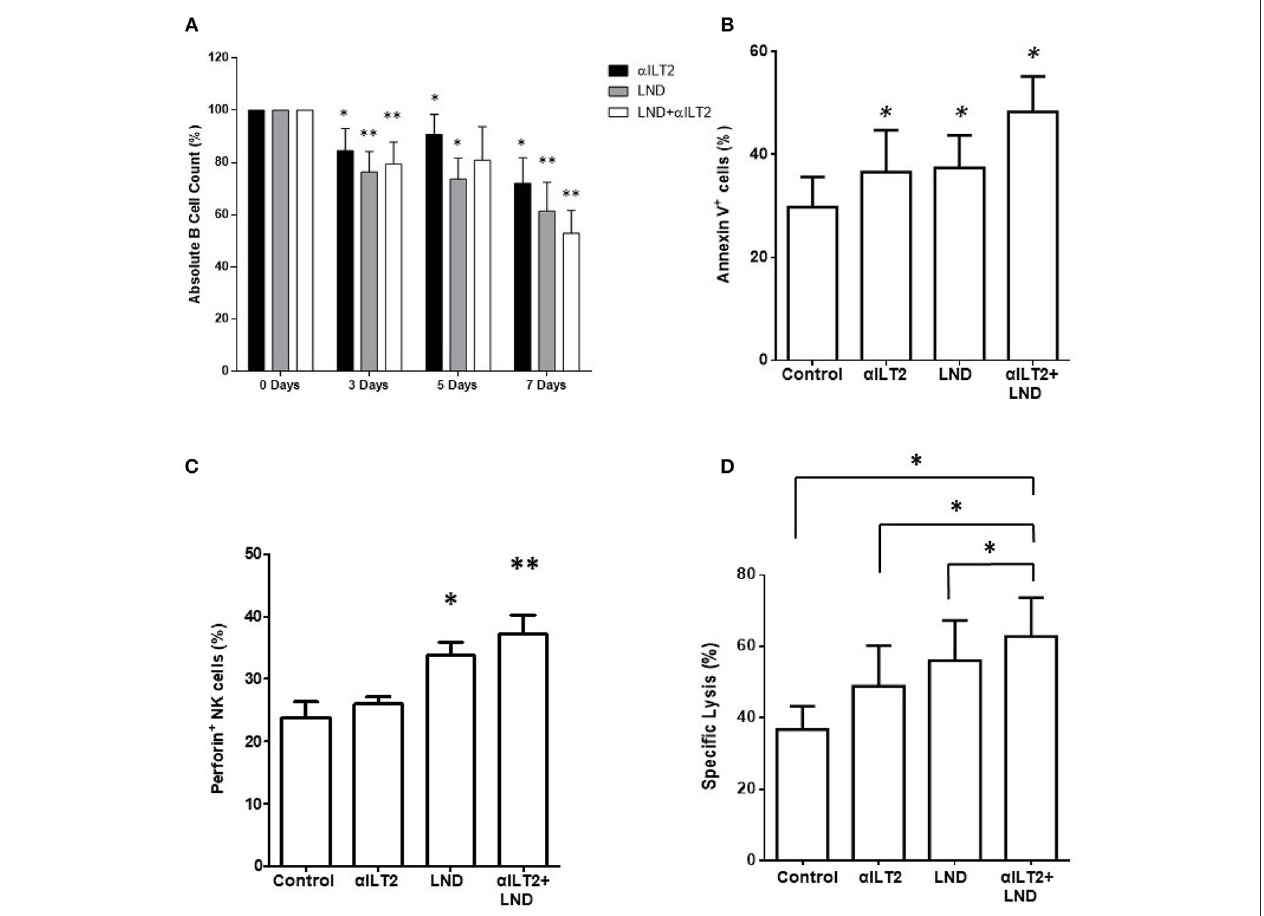
FIGURE 7 | ILT2 blockade and lenalidomide promote NK cell cytotoxicity and the elimination of primary leukemic cells from patients with CLL. PBMCs obtained from 6 CLL patients were cultured in the presence of anti-ILT2 blocking antibody (10 µ g/ml) or irrelevant IgG 1 and lenalidomide (LND, 1 µ M) for the time points indicated. (A) The absolute numbers of leukemic cells were then analyzed after 3, 5, and 7 days of treatment by staining with anti-CD19 antibody and PKH26 microbeads as a reference. (B) The effect of ILT2 blockade and lenalidomide (7 days) on the apoptosis of leukemic cells was evaluated by annexin V assay by flow cytometry ( n = 11). (C) NK cell intracellular perforin expression was evaluated by flow cytometry analysis in PBMCs from 6 patients with CLL upon 7 days of treatment with anti-ILT2 blocking antibody (10 µ g/ml) or irrelevant IgG 1 and lenalidomide (LND, 1 µ M). (D) NK cell cytotoxic activity against K562 leukemia cells after a week of treatment with anti-ILT2 blocking antibody (10 µ g/ml) or irrelevant IgG 1 and lenalidomide (LND, 1 µ M) was evaluated by calcein assay ( n = 5). Bars represent the mean ± SEM of the different treatments used. SEM, Standard Error of the Mean; Wilcoxon Matched-Pairs Signed Ranks test; * P < 0.05, ** P <